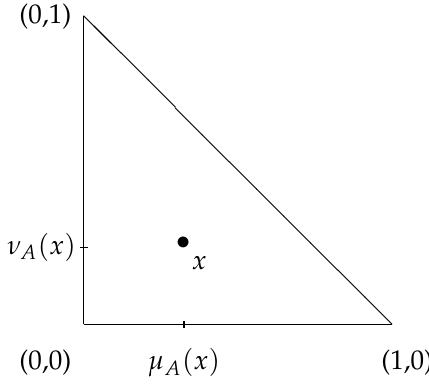
Figure 1. The geometrical interpretation of an element x Fig. 1: The geometrical interpretation of an element x